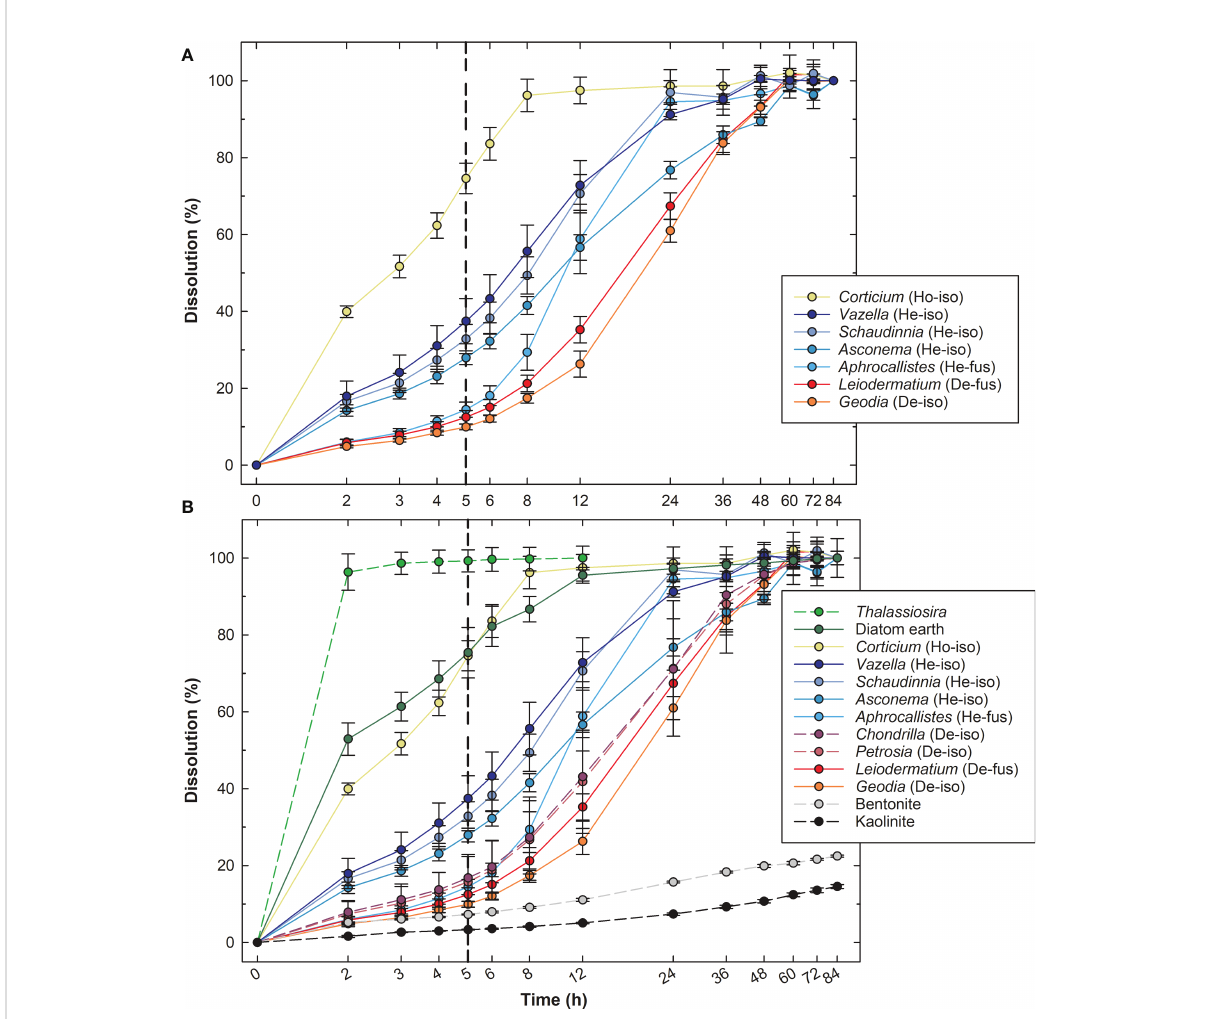
FIGURE 2 Dissolution (%; average ± SD) dynamics of various siliceous materials in 1% sodium carbonate in gentle agitation during 84 h. (A) Comparative dissolution of major types of sponge siliceous skeletons assayed in the current study: small isolated spicules of Corticium candelabrum in the Class Homoscleroemorpha (Ho-iso); delaminating, isolated spicules of three rosellids species, Vazella pourtalesii , Schaudinnia rosea , Asconema setubalense in the Class Hexactinellida (He-iso); spicules of Aphocallistes vastus fused in a dictyonal silica framework (He-fus); desmas of Leiodermatium pfeifferae fused in a silica framework in the Class Demospongiae (De-fus); isolated spicules from the rootlets of Geodia hentscheli in the Class Demospongiae (De-iso). (B) Comparison of the dissolution dynamics of the above described sponge skeleton types in comparison with those of diatom Thalassiosira weiss fl ogii , diatom earth, isolated aster-like spicules of demosponge Chondrilla caribensis (De- iso), isolated needle-like spicules of desmosponge Petrosia fi ciformis (De-iso), and aluminosilicates bentonite and kaolinite, as detailed in Maldonado et al. (2019), and herein represented by dashed lines. Note that the representation of the dissolution line of T. weiss fl ogii and C. candelabrum ends at 12 h and 60 h, respectively, because silica dissolution is virtually